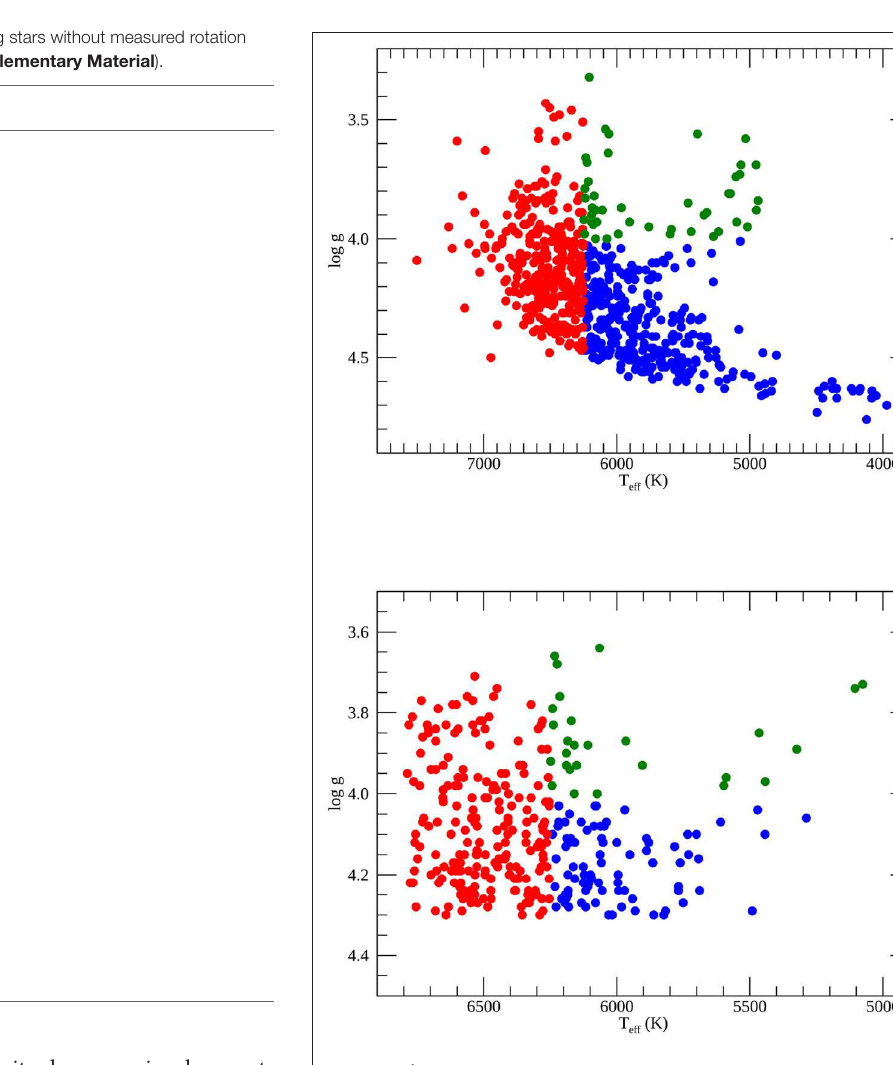
FIGURE 4 | HR Diagram showing the hot dwarfs (red symbols), cool dwarfs (blue symbols), and subgiants (green symbols) as described in section 4. Top panel: all the non-oscillating stars with a measurement of rotation periods. Bottom panel: stars selected from the cut described in section 2.3 with a measurement of rotation